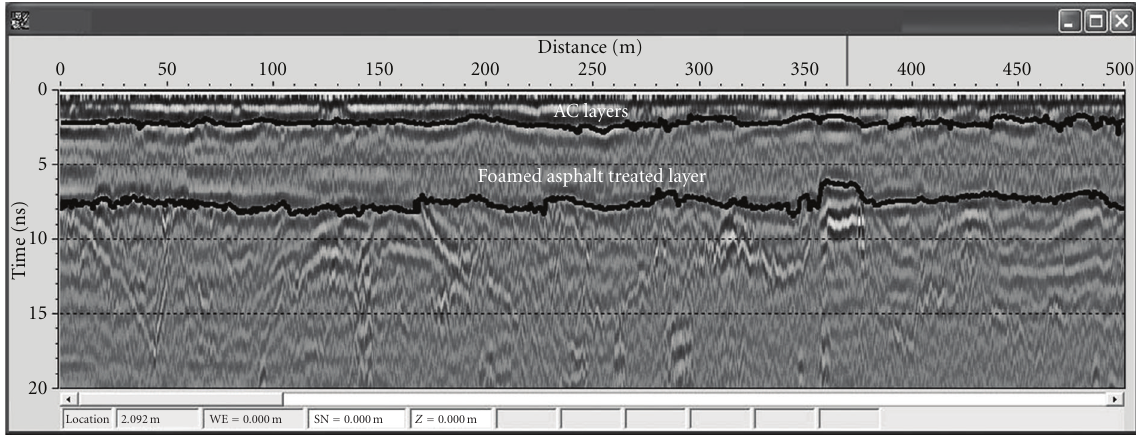
Figure 11: GPR data interpretation for the thickness estimation of the AC